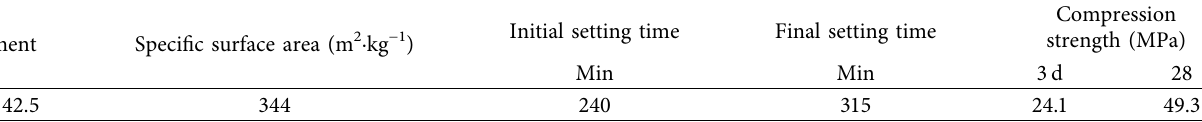
Table 2: Basic physical and mechanical properties of cement.